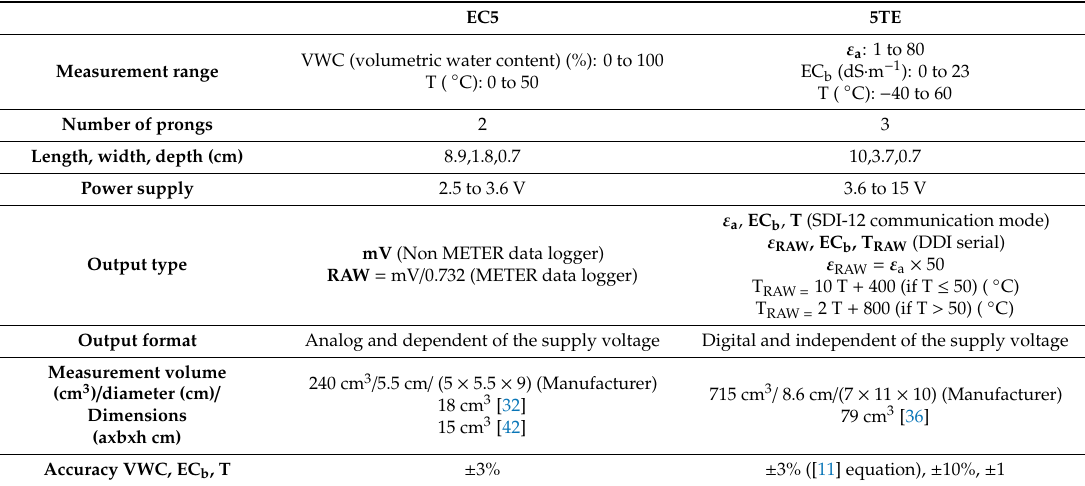
Table 1. Characteristics of the two sensors EC5 and